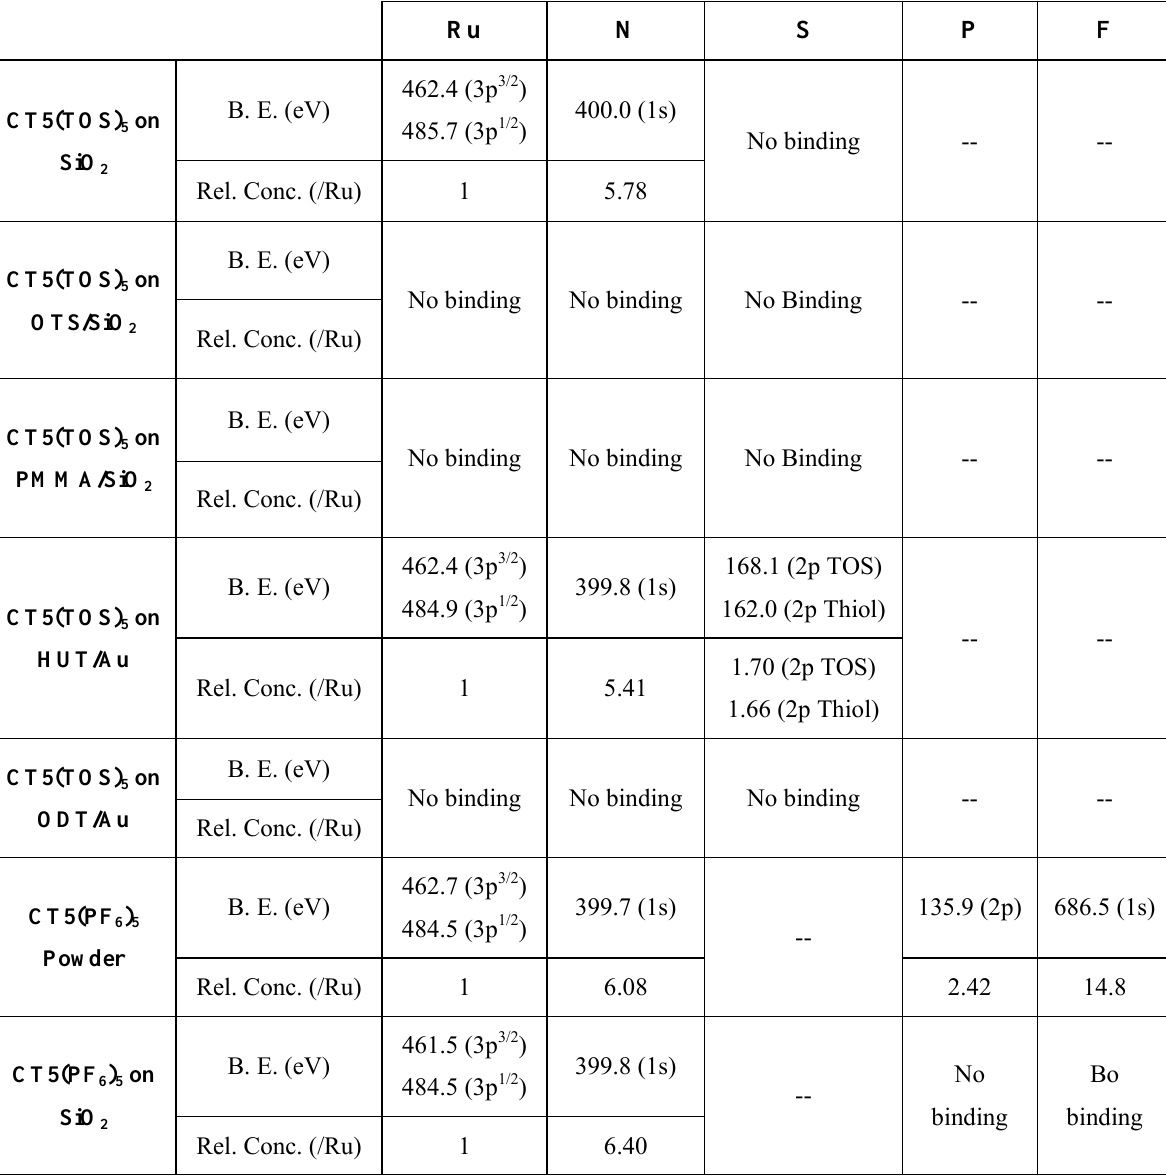
Table 2. Selective binding properties of the Creutz-Taube ions (CT5) on hydrophilic and hydrophobic